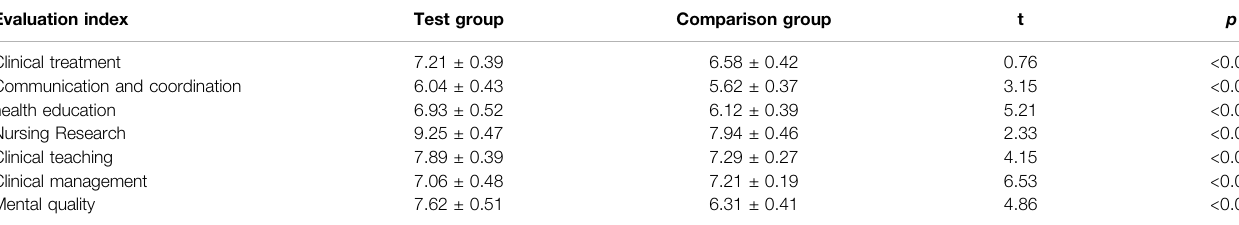
TABLE 5 | Results of emergency clinical ability of the two groups after 4 weeks of